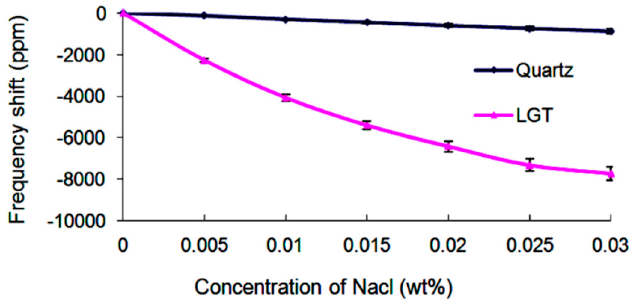
Figure 4. Frequency changes of different LFE devices for different concentrations of NaCl aqueous solutions.